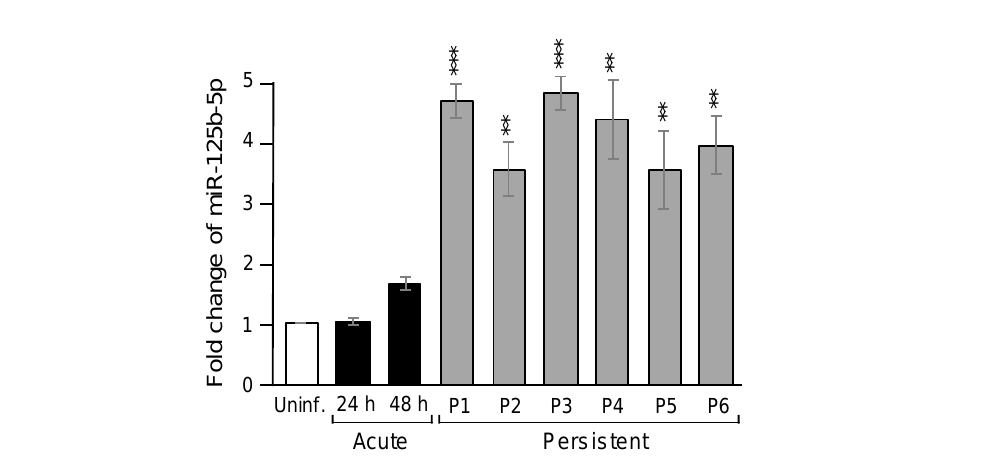
Figure 2. The miR-125b-5p was immediately elevated once established persistent infection. The total RNA was extracted from uninfected, acutely infected (24 and 48 hpi at an MOI of 0.1), and persistently infected cells from passages 1 to 6 (P1–P6). The RNA was subjected to an RT reaction and analyzed by RT-qPCR. The relative fold change was normalized to endogenous U6 snRNA. Bars represent the mean ± SD ( n = 3). **: p -value < 0.01, ***: p -value < 0.001 comparison between acute (48 hpi) and persistent infection was analyzed by Student’s t -test.